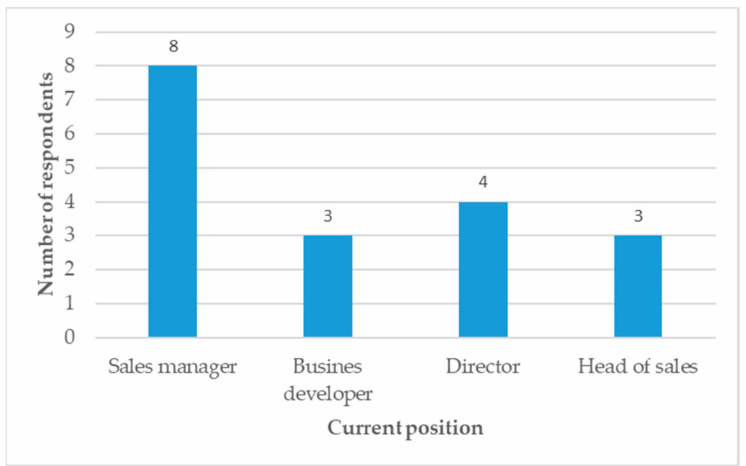
Figure 1. Current positions of the responding